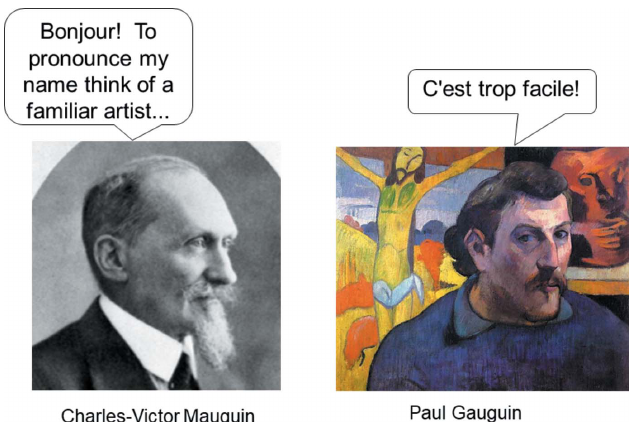
Figure 11 Link to pronunciation slide.